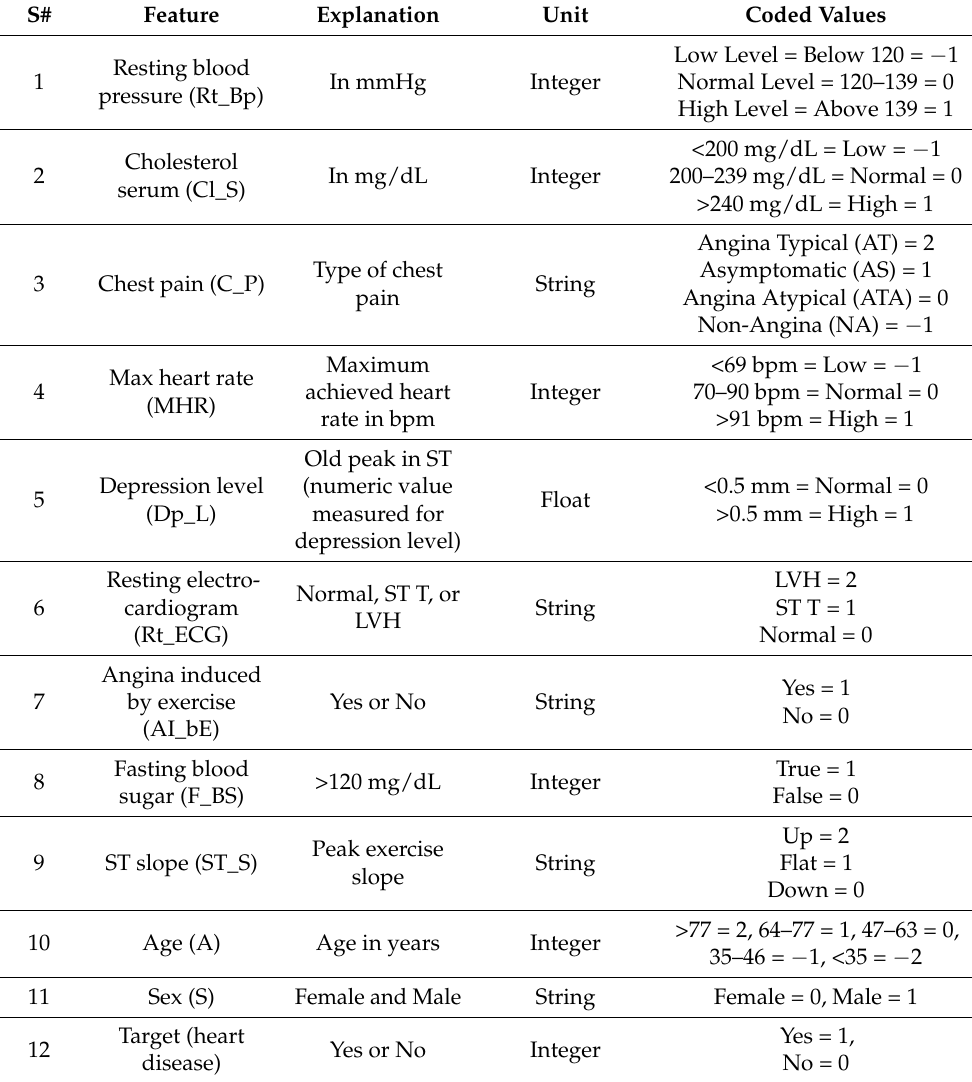
Table 2. Thorough description of the combined